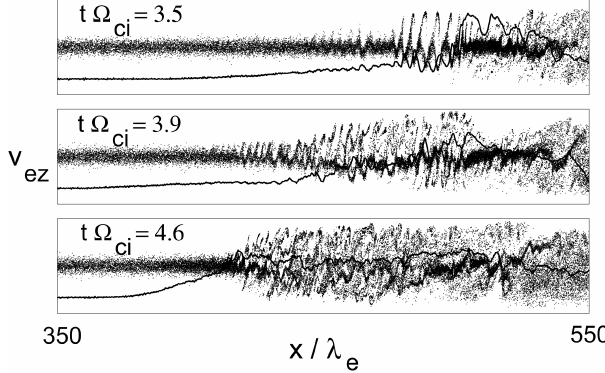
Fig. 11. Electron v ez − x phase space at three different times during a reformation cycle. Superposed are the B z magnetic field